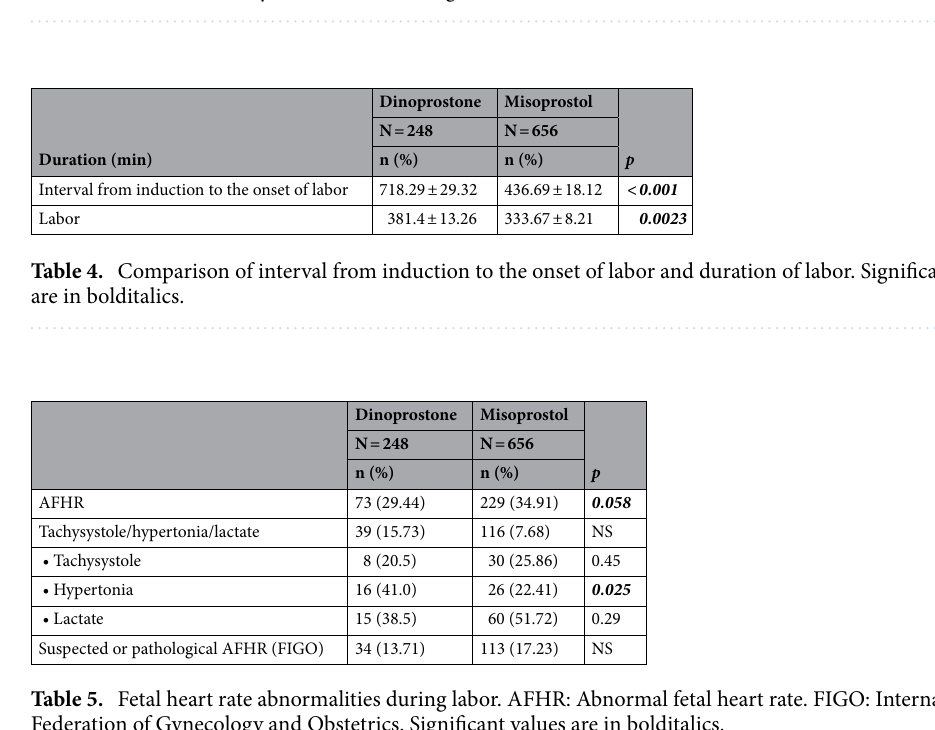
Table 3. Mode of delivery before 37 weeks of gestation.